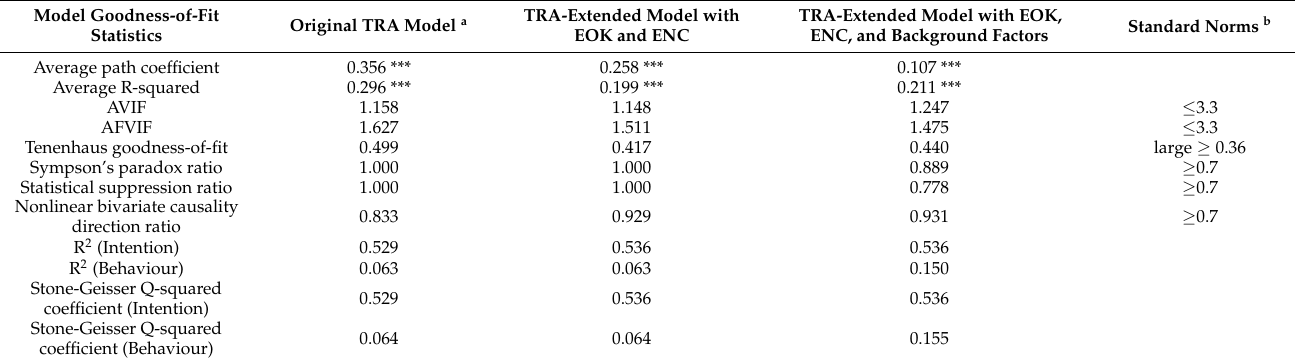
Table 7. Goodness-of-Fit